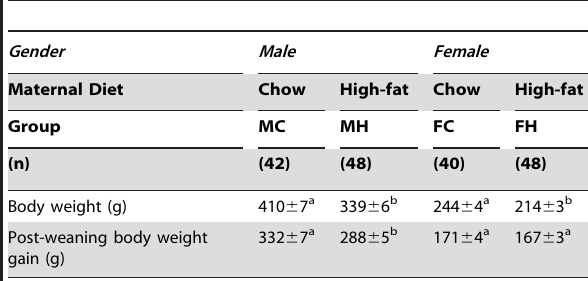
Table 3. Body weights and post-weaning body weight gains of offspring born to dams fed the chow (C) or the high-fat (H) diet and fed the chow diet for 7 weeks since